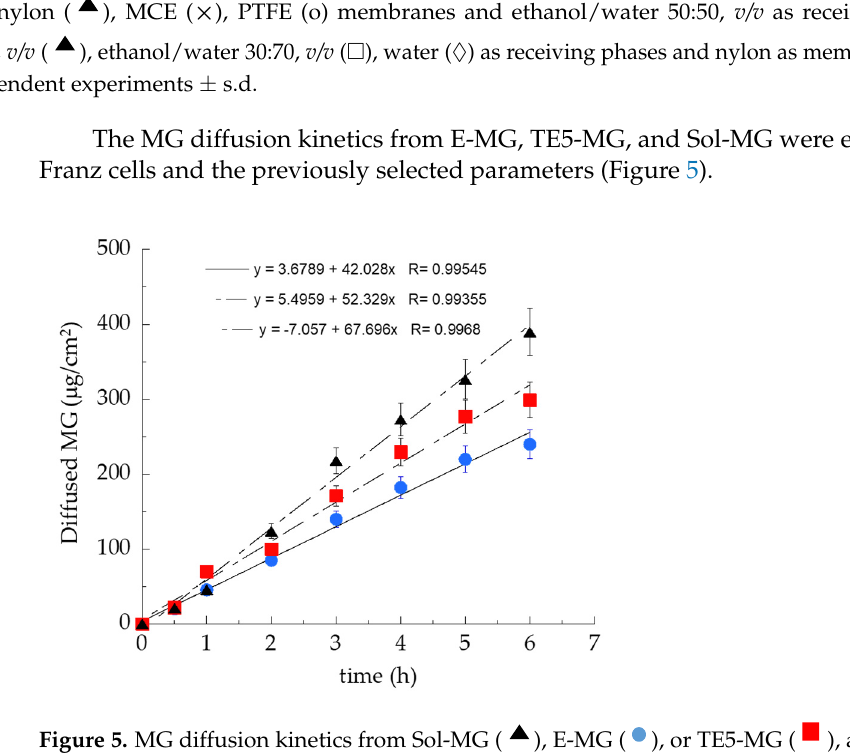
Figure 5. MG diffusion kinetics from Sol-MG ( ), E-MG ( ), or TE5-MG ( ), as determined by the Franz cells assembled with the nylon membrane and ethanol/water 50:50 v/v as receiving phase. Data are the mean of 6 independent experiments ± s.d. MG diffusion trend was Sol-MG > TE5-MG > E-MG. F values, corresponding to the slopes of the diffusion profiles, and D values, calculated dividing F by MG concentration (mg/mL) in the different forms, are reported in Table 4. Both E-MG and TE5-MG con- trolled MG diffusion with respect to the simple Sol-MG. Particularly, MG diffusion from TE5-MG was 1.84-fold slower compared to Sol-MG and 1.24-fold faster compared to E- MG. The differences in diffusion found in the case of TE5-MG compared to E-MG could be attributed to the alteration of the packing density of PC bilayers due to TW 80 position-